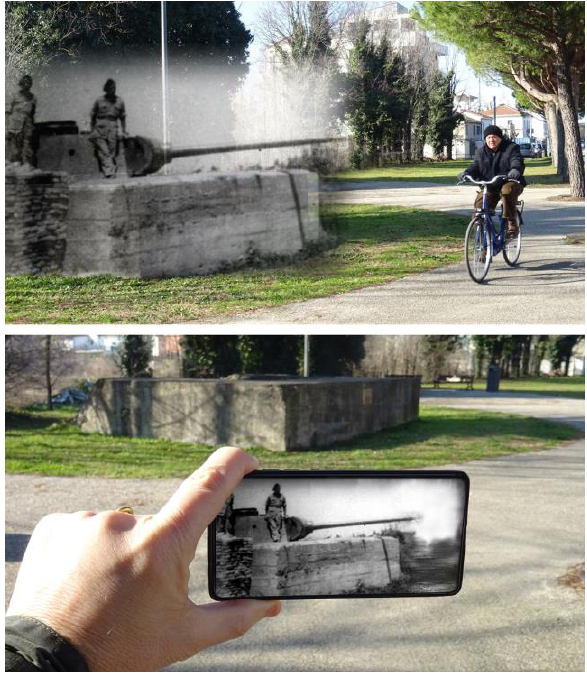
Figure 6. Augmented reality simulation. © Bostrenghi,